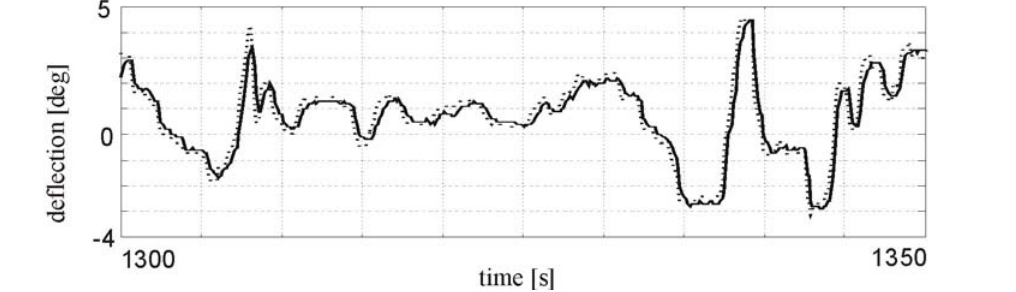
Fig 10. Aileron positioning during flight tests (03-10-24, 08:47:59 GMT); solid –deflection, dotted – desired value